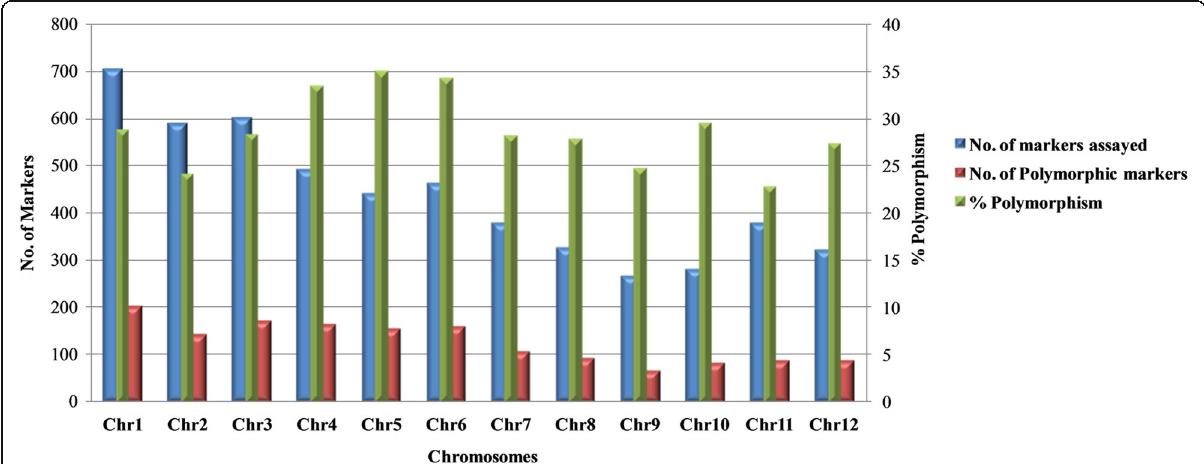
Fig. 3 Chromosome-wise polymorphism survey using 5K SNP array and polymorphic SNPs in Nagina22 x IR64 mapping population